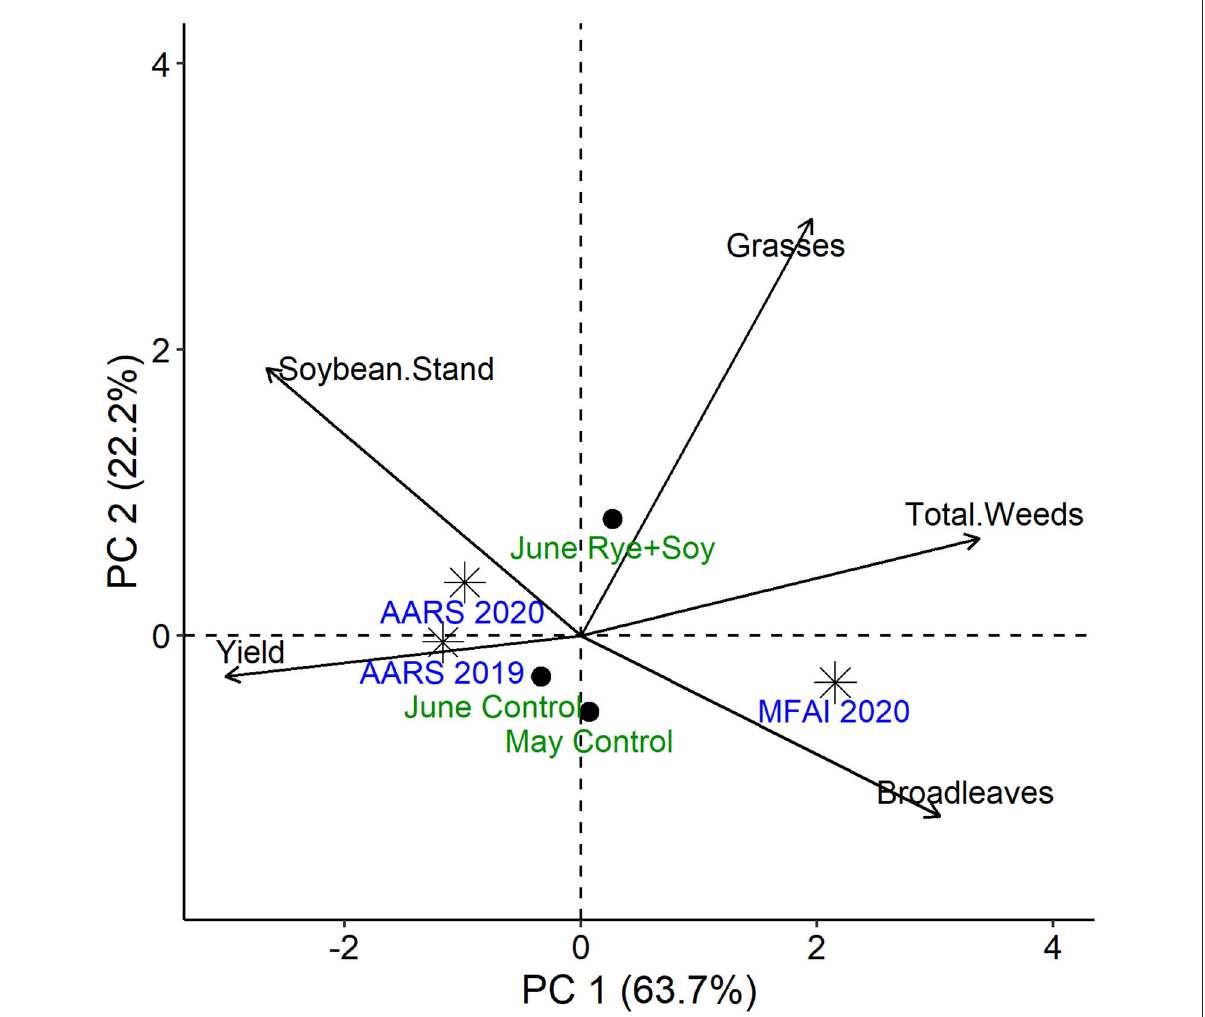
FIGURE3 Principal component (PC) plot superimposed with eigenvectors of treatments and site years in relation to measures of weed biomass (kg ha − 1 ), soybean plant stand (plants ha − 1 ), and soybean grain yield (Mg ha − 1 ). Treatment abbreviations: June Rye + Soy (rye interseeded with June-planted soybeans), May Control (tilled soybeans without rye seeded in May), June Control (tilled soybeans without rye seeded in June). Site year abbreviations: AARS, Arlington Agricultural Research Station; MFAI, Michael Fields Agricultural